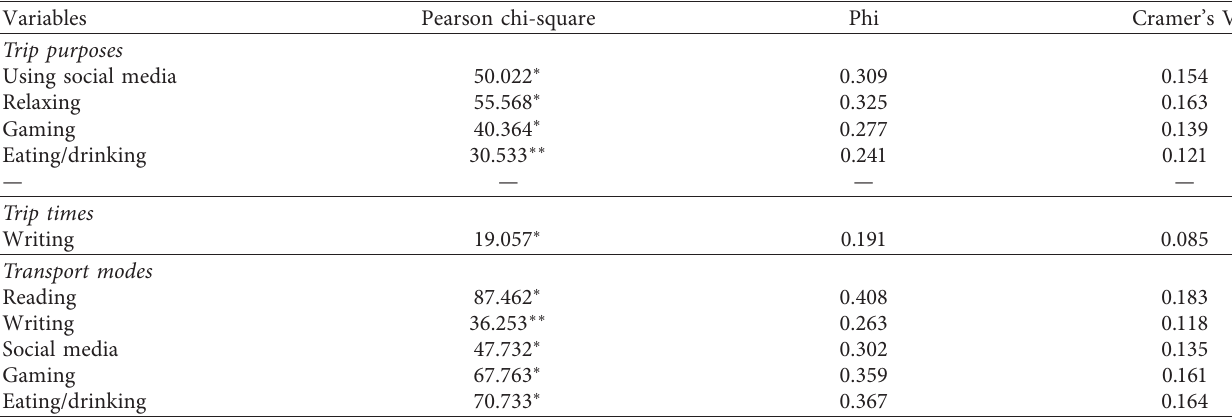
Table 4: The chi-square test and the symmetric measures of the trip purpose, the transport mode, and the trip time across onboard activities.